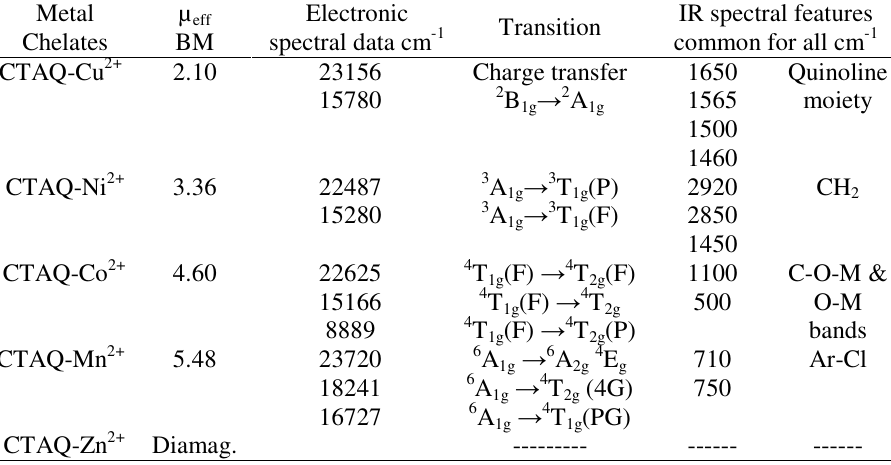
Table 2. Spectral features and magnetic moment of CTAQ metal